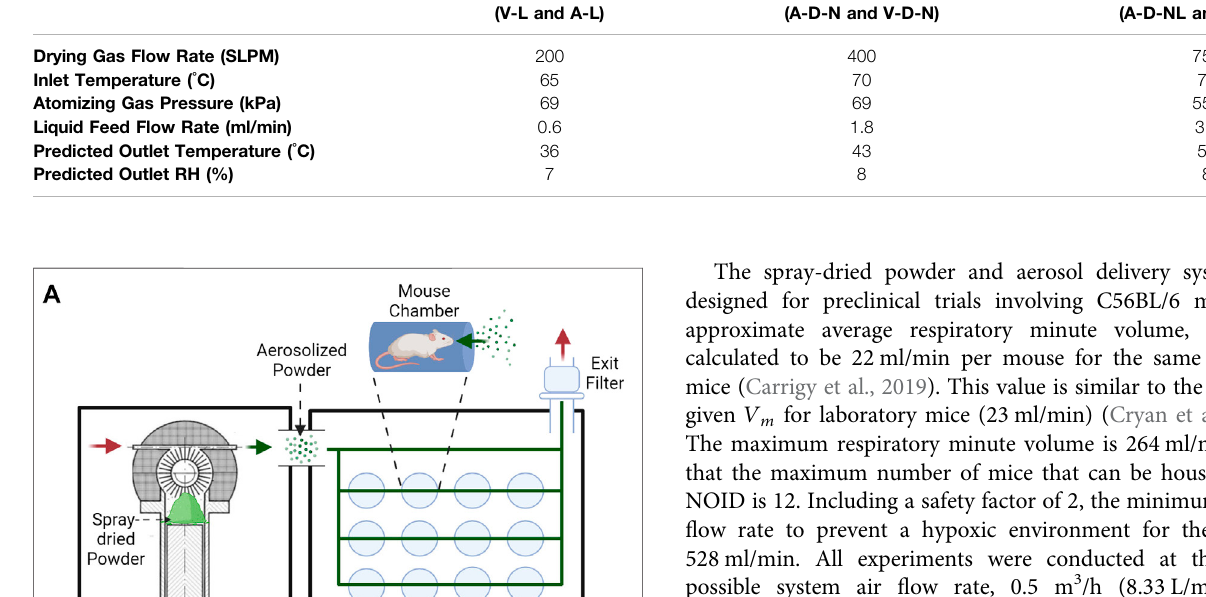
TABLE 4 | Spray drying processing parameters used for manufacturing powder for preclinical trials. Nomenclature: V – Vaccine; A – Adjuvant; L – Liquid; D – Dry powder; N – Nose; NL – Nose and Lung. Parameters